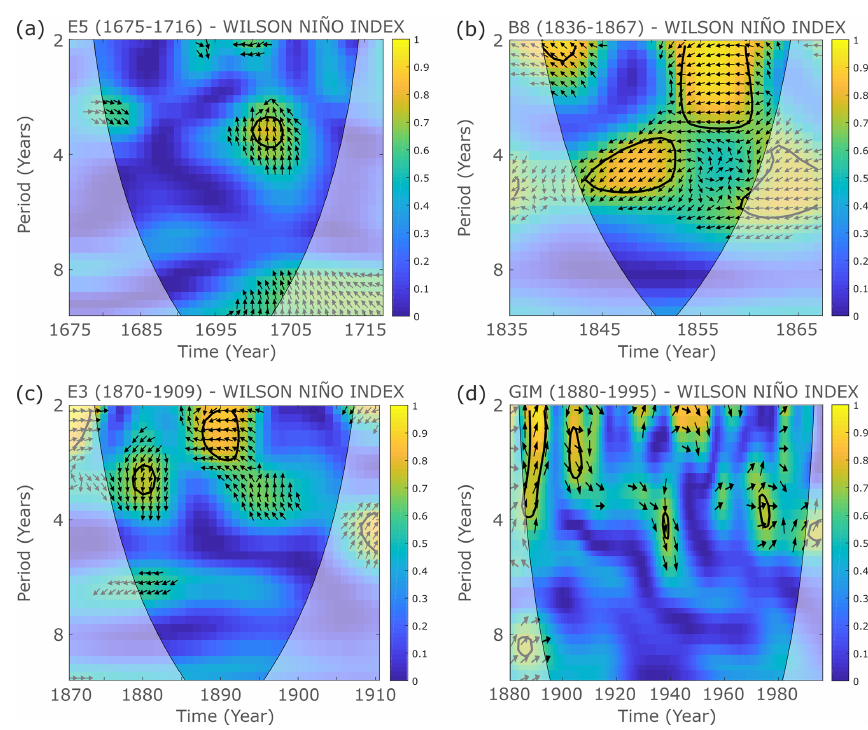
Figure 6. Wavelet coherence analysis plots for the Wilson Niño index (Wilson et al., 2010) and Chagos coral SST of (a) E5 (1675–1716), (b) B8 (1836–1867), (c) E3 (1870–1909), and (d) GIM